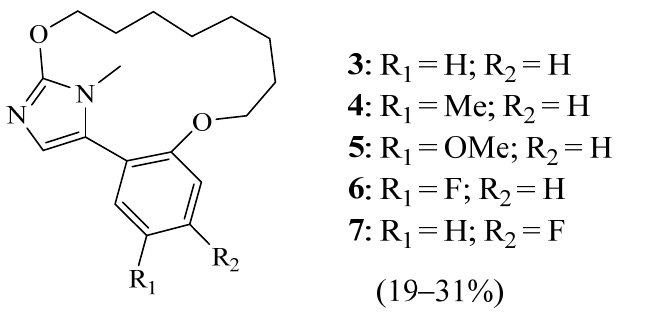
Figure 2. Structures of macrocycles reported by Nshimyumukiza et al. [16]. (Reprinted with per- mission from ref. [16]. Copyright 2010 Elsevier).